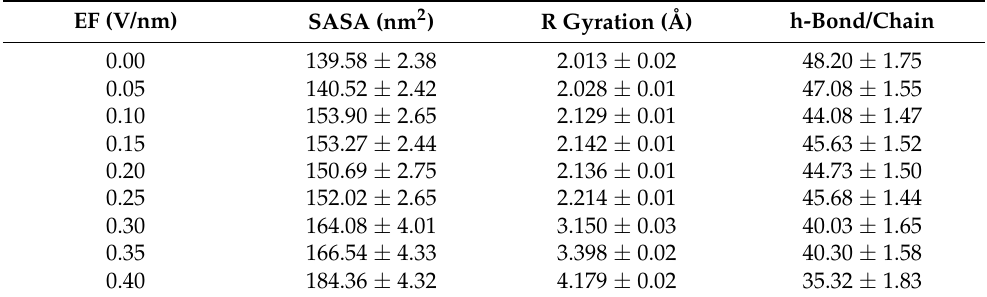
Table 2. The solvent-accessible surface area, the radius of gyration and the number of hydrogen bonds per chain calculated from the last 200 ns of the simulation